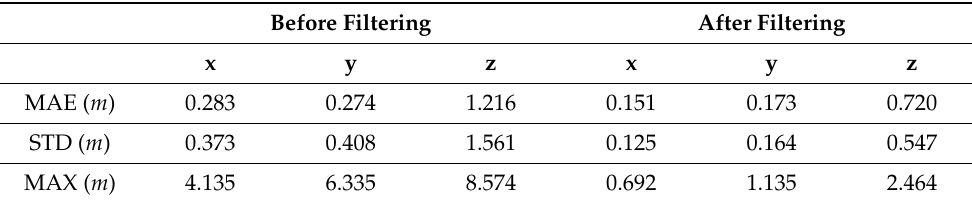
Table 1. Statistical results of geolocation in the experiment of corresponding point matching.